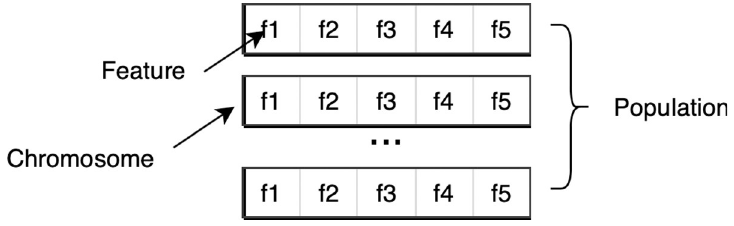
Fig 6. Features, chromosomes and